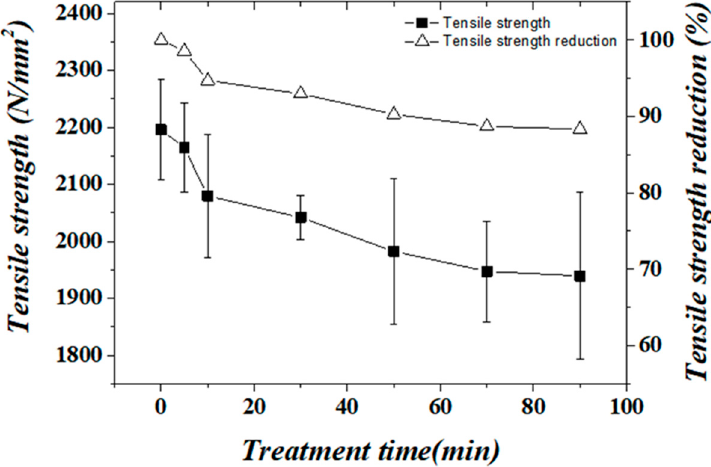
Figure 8. Effect of the acid-treatment time on the stress–strain curves of the stainless-steel fiber .